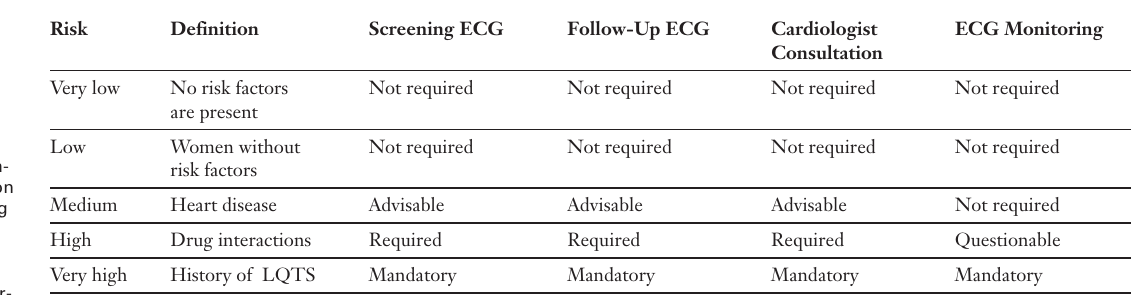
Proposed practical approaches when prescribing non-an- tiarrhythmic drugs known to prolong the QT interval in pa-